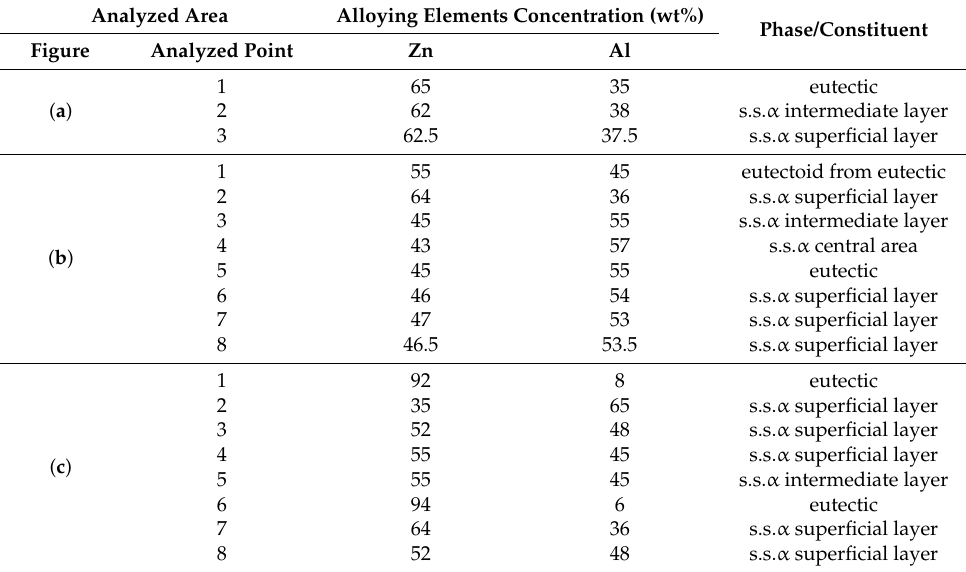
Table 3. Composition of the areas indicated in Figure 5.